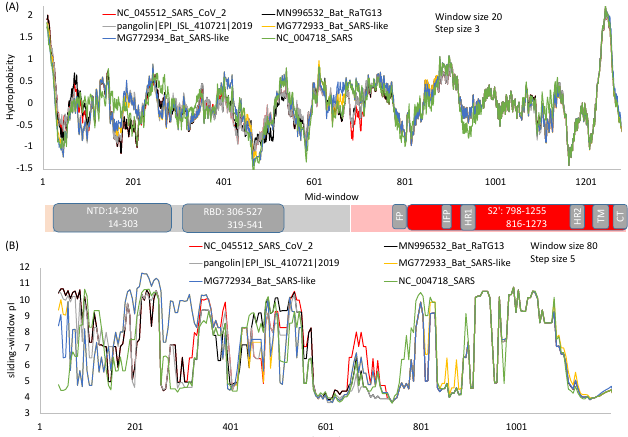
Figure 3. Hydrophobicity ( A ) and protein isoelectric point ( B ) plots of spike protein from SARS- CoV-2 and its close relatives over sliding windows. For window-specific calculation of isoelectric point (pI), the N -terminus amino group is added to the first window and the C -terminus carboxyl added to the last window. Generated from DAMBE [49].